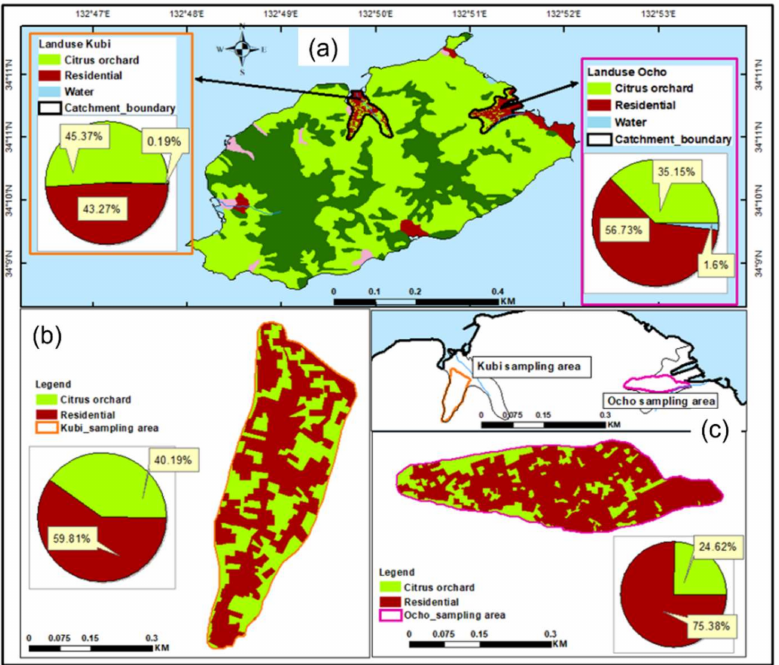
Figure 2. Land use of Osakishimojima, showing proportions of citrus orchards and residential areas in ( a ); Kubi and Ocho lowland areas, ( b ); Kubi sampling area, and ( c ); Ocho sampling